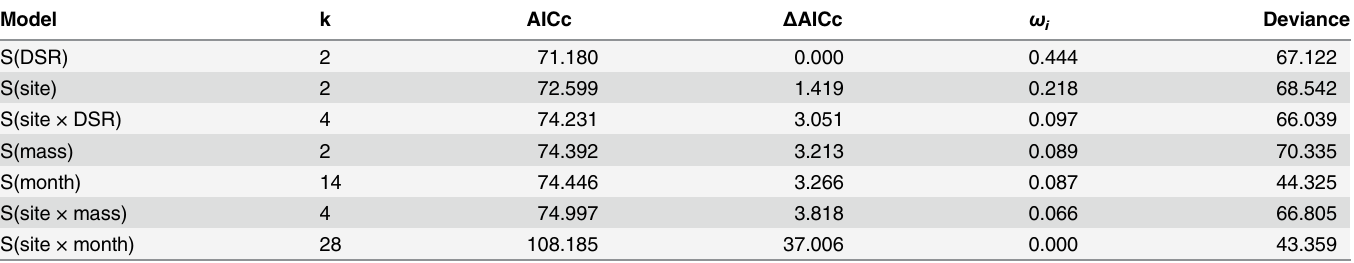
Table 1. Model selection results for survival analysis of captive-reared Chinese giant salamanders reintroduced in two rivers in the Qinling Moun- tains, Shaanxi Province, China, 2013 – 2014. Model